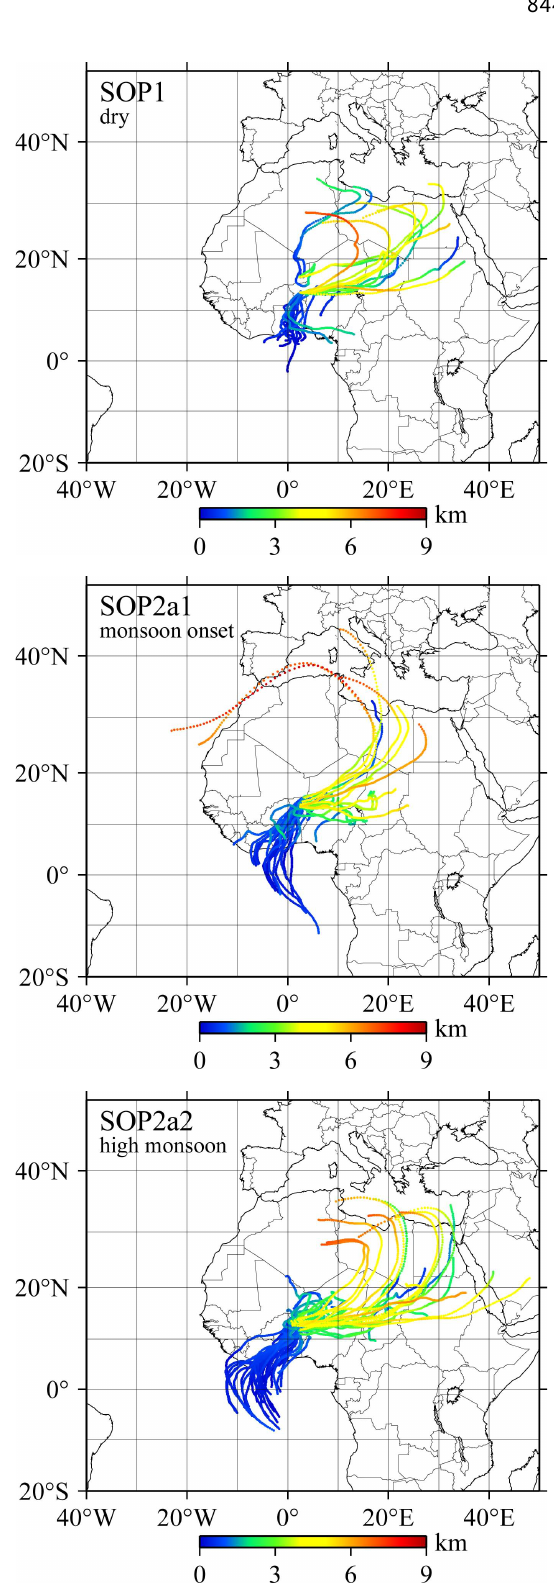
Fig. 3. Five-day backward trajectory calculations of air-masses arriving along the tracks of the ATR-42 aircraft during the three AMMA